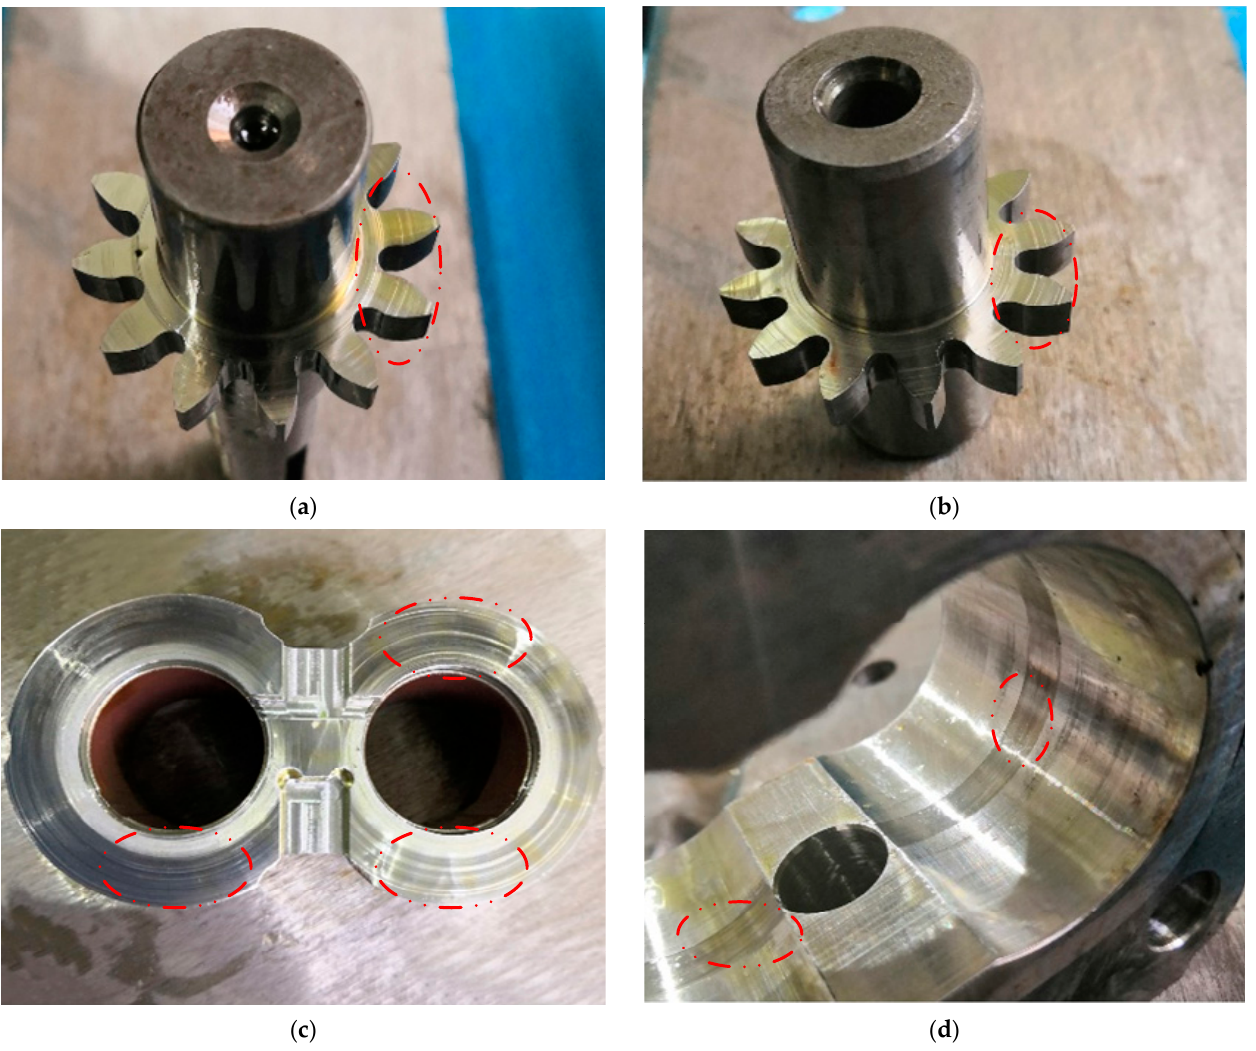
Figure 10. Wear of each component of gear pump: ( a ) end-face wear of driving gear; ( b ) end-face wear of driven gear; ( c ) side plate wear; and ( d ) pump body wear.